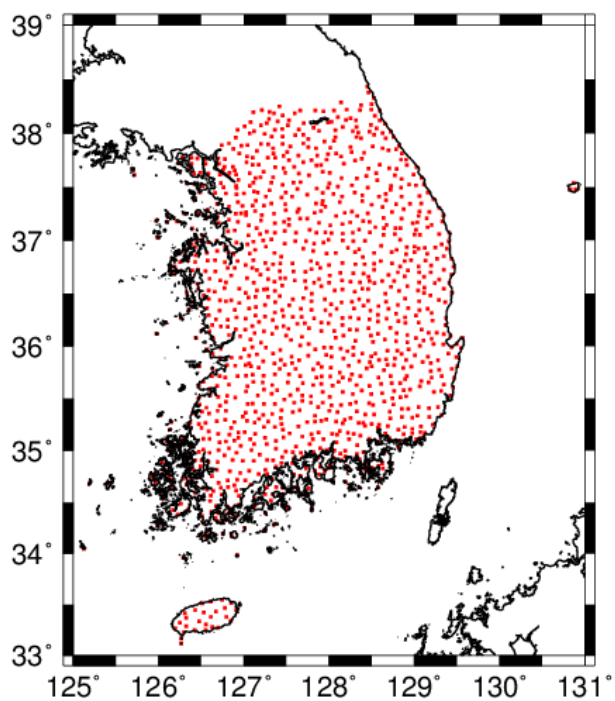
Figure 1. Location map of the 1182 GNSS/leveling UCPs in South Korea that were used in this study for the evaluation of the geoid heights in the study area.